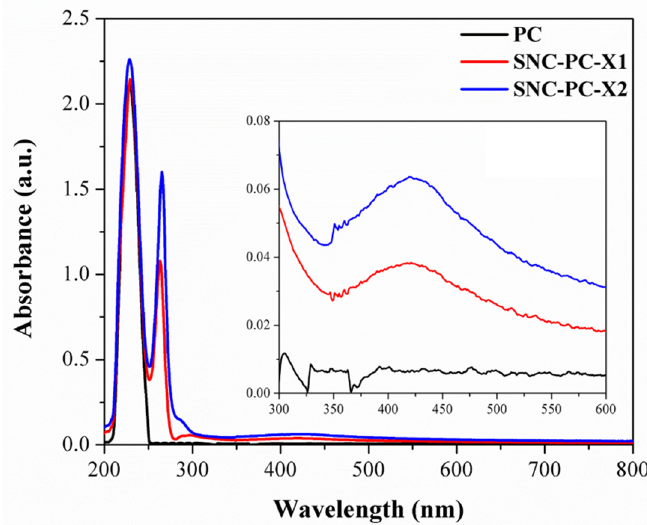
Figure 2. UV-Vis spectrum of 2-weight % solutions of PC, SNC-PC-X1 and SNC-PC-X2 in Tetrahydrofuran (THF) solvent.